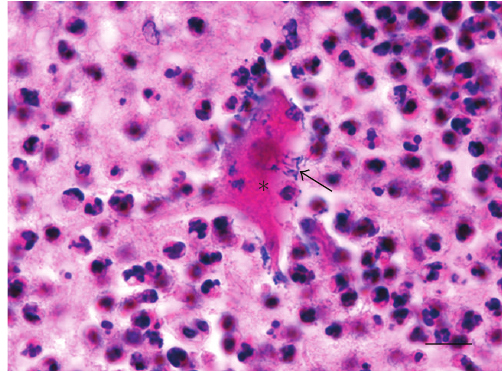
Figure 5: Rhombencephalitis in a sheep: necrotic neuron (asterisk) with intraneuronal Listeria monocytogenes (arrow) in a microab- scess of the medulla oblongata. H&E, bar = 13 μ m.